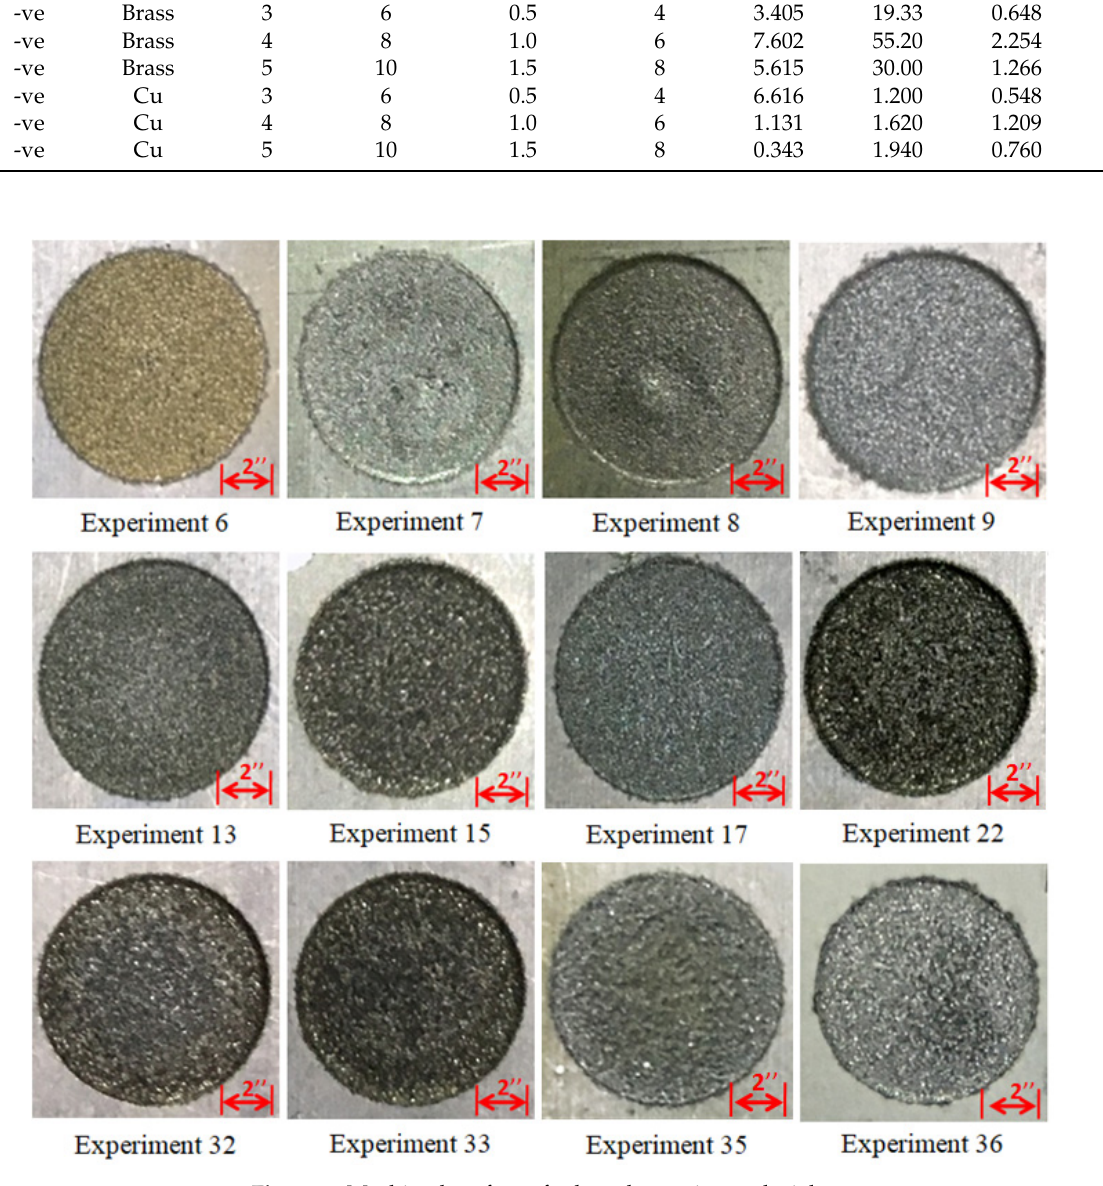
Figure 5. Machined surface of selected experimental